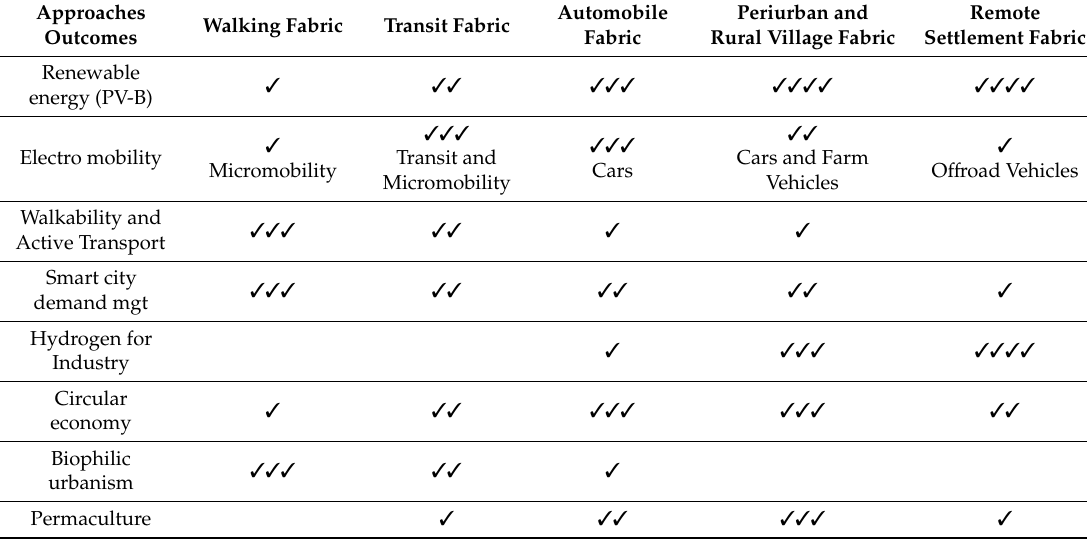
Table 3. Technological approaches for the new economy and how they relate di ff erently to five types of urban